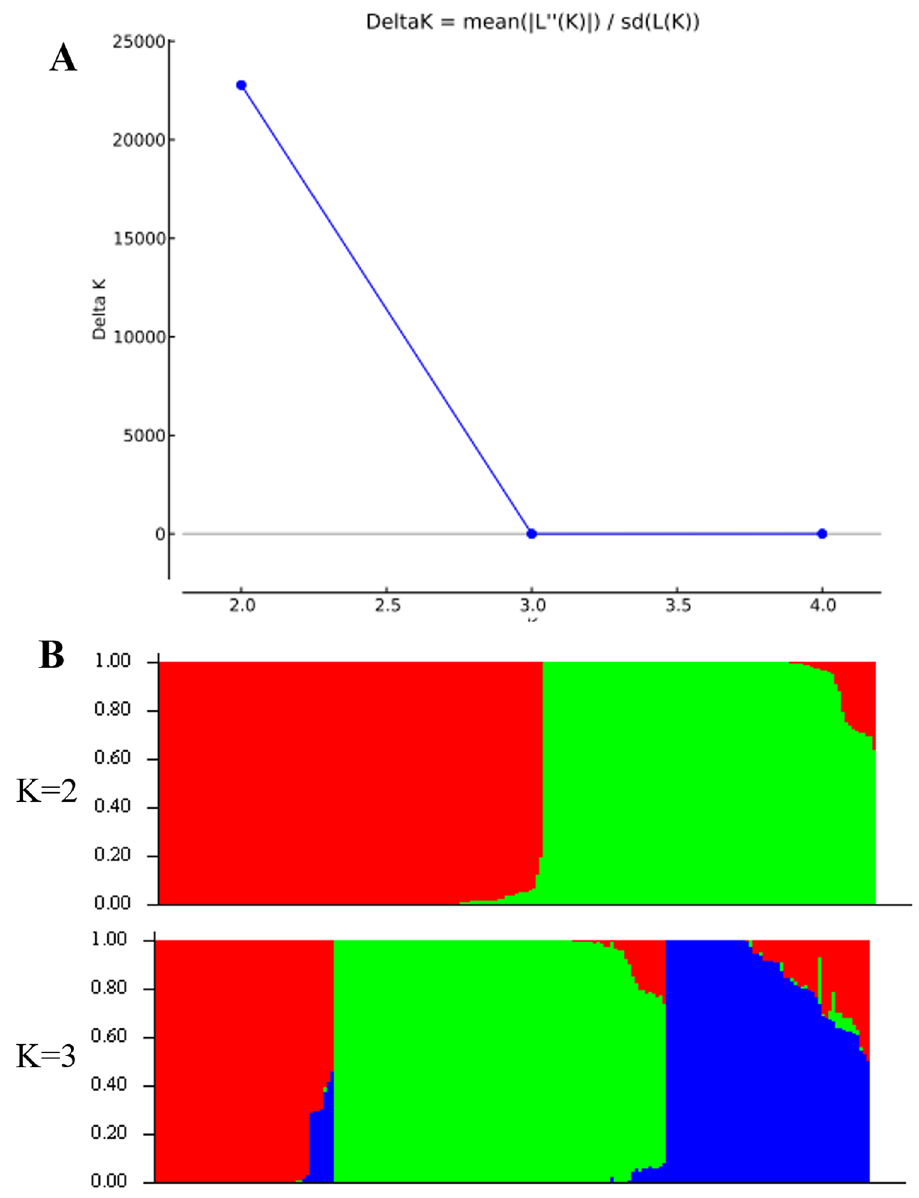
Figure 3. Population structure analyses of 207 genotypes in the Merge set based on the high-resolution 4475 SNPs assessed by STRU CTU RE (http:// pritch. bsd. uchic ago. edu/ struc ture. html). ( A ) Determining delta K values for different populations ( K = 2) or 3 clusters ( K = 3). ( B ) Bar plot for the K value 2 or 3. Population structure analysis was performed using admixture 1.3 43 . Color segments represent different groups inferred by STRU CTU RE